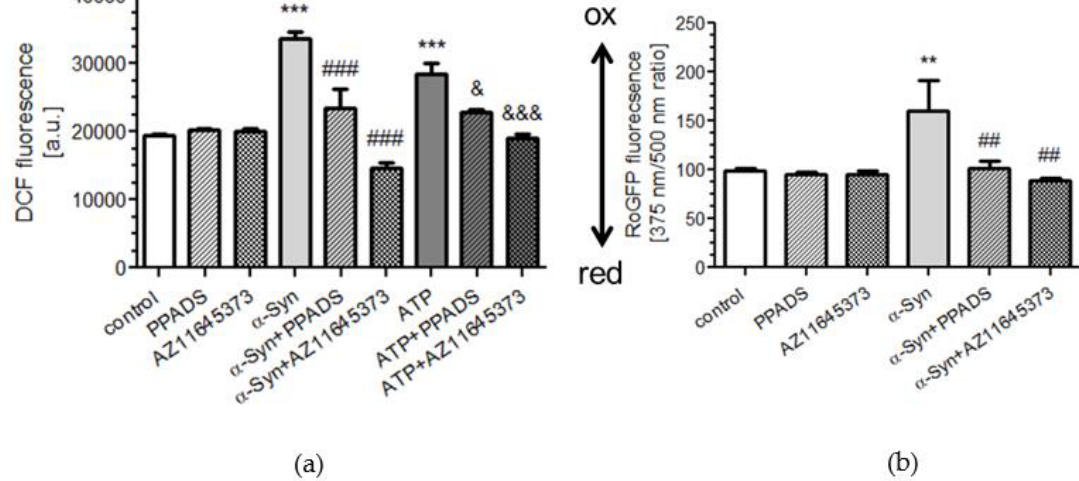
Figure 2. The involvement of P2X7R in oxidative stress generation in SH-SY5Y cells treated with exogenous α -Syn. ( a ) Intracellular free radicals level in SH-SY5Y cells after 8 h incubation with 10 µ M α -Syn or 1 mM ATP in the presence of 100 µ M PPADS or 10 µ M AZ 11645373 (measured by DCF fluorescence. Data represent the mean value ± S.E.M. for four independent experiments. *** p < 0.001 compared to control, ### p < 0.001 compared to α -Syn, and & p < 0.05, &&& p < 0.001 compared to ATP using one-way ANOVA followed by Bonferroni post hoc test. ( b ) Oxidative-reduction potential in SH-SY5Y cells after 8 h incubation with 10 µ M α -Syn in the presence of 100 µ M PPADS or 10 µ M AZ 11645373 measured by RoGFP fluorescence. Data represent the mean value ± S.E.M. for five independent experiments. ** p < 0.01 compared to control and ## p < 0.01 compared to α -Syn, using one-way ANOVA followed by Bonferroni post hoc test.